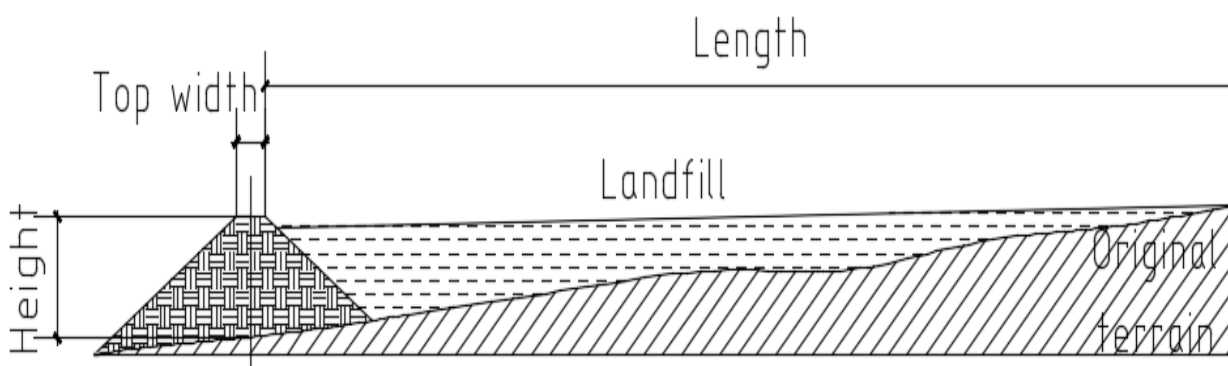
Figure 6. Gully land consolidation profile ( λ